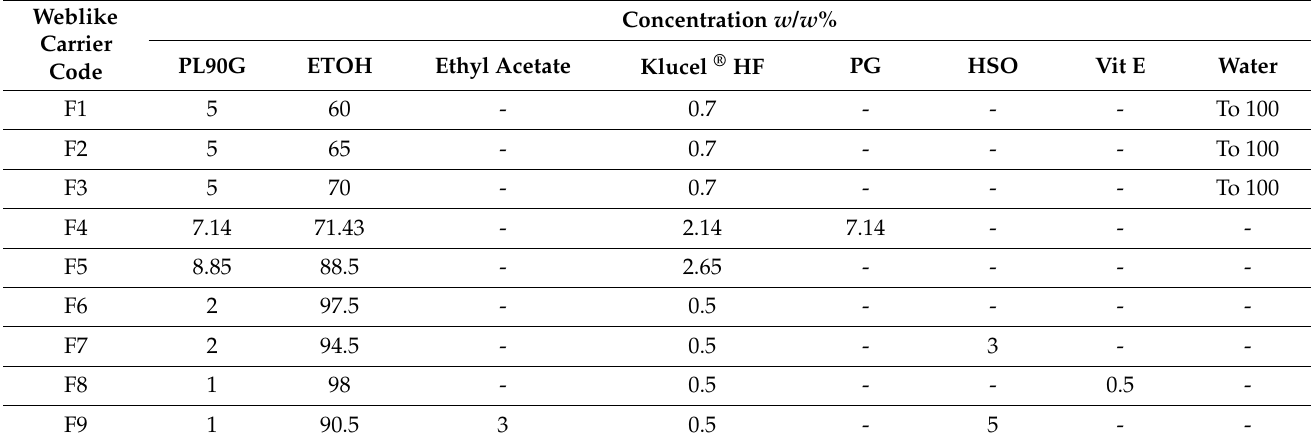
Table 1. Composition of Weblike carrier